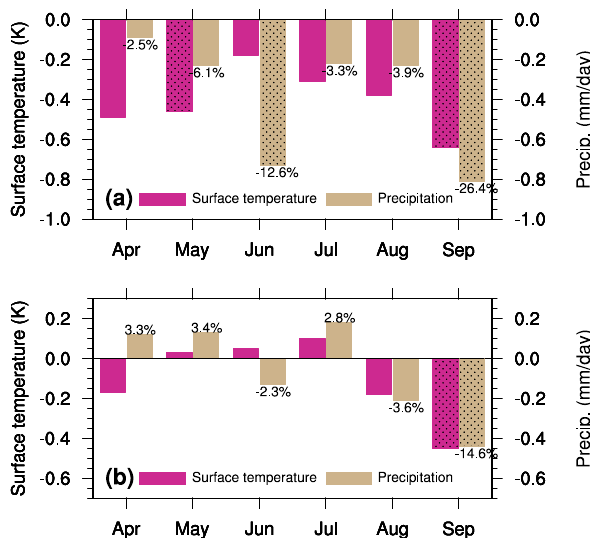
Fig. 5. Changes in monthly area mean surface temperature (red, units: K) and precipitation (green, units: mmday − 1 ) over East Asia continent (20–45 ◦ N, 100–122 ◦ E). (a) Change in sulphate experiment (Control minus SO 2 1950). (b) Change in black carbon experiment (Control minus BC 1950). The percentage over each precipitation bar is percentage changes of precipitation against Control experiment. Significant changes excess 95% confident level are hatched.